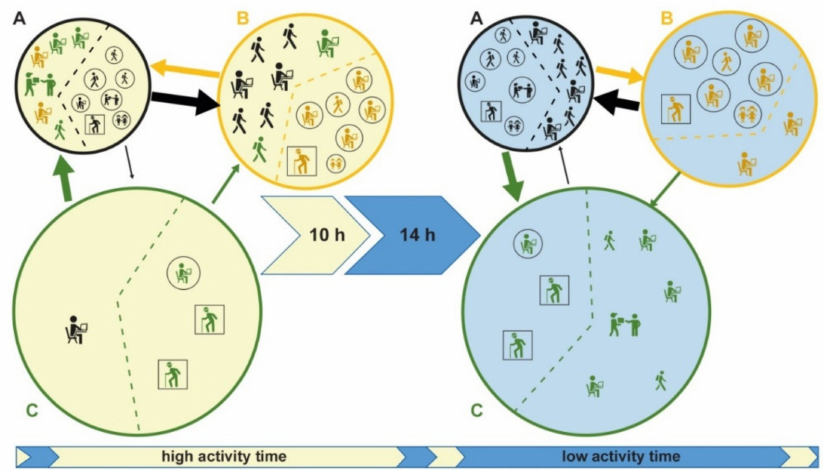
Figure 3. A typical working day description considering three di ff erent municipalities and populations. Population changes due to commuting in two di ff erent times of the day (high activity and low activity). The municipalities, A, B, and C are displayed by circles in black, yellow, and green; the icons, colored according to the circles, represent the resident populations in the 3 municipalities; squared icons represent noncommuters resident (R) and circled icons commuters inside the node (C r ); the arrows represent commuters moving daily from a source to a destination (C o and C i ) and the arrow’s size is proportional to the number of moving commuters. Municipality C, with a population of 10, decreases to 4 during the day, due to a prevalent component of outgoing commuters (C o = 7). Conversely, the population in B increases significantly during the day, due to the higher incoming commuters (C i = 8). Municipality A has a balanced population during the entire day, having an equivalent C o and C i